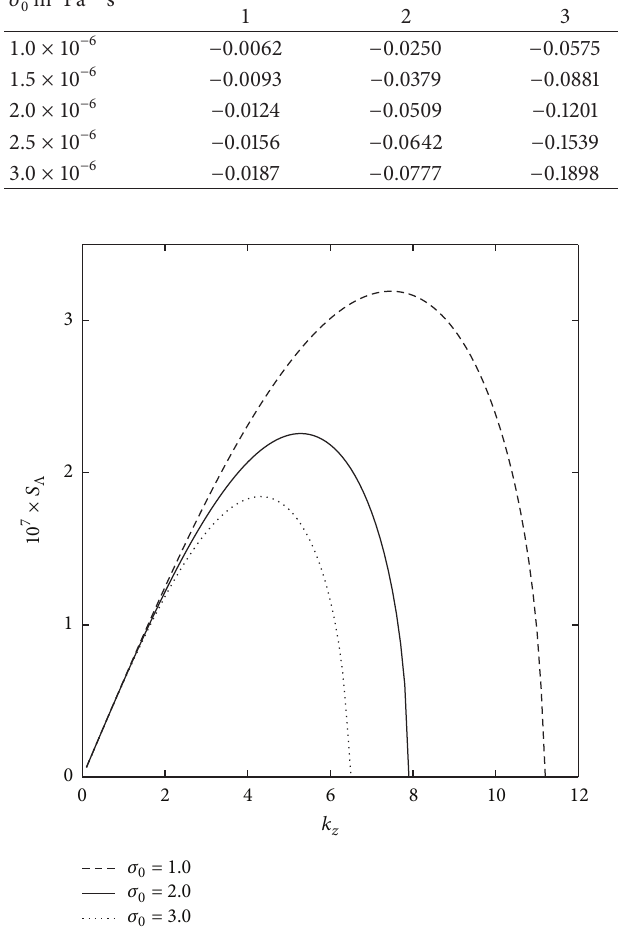
Figure 5: Sensitivity function 𝑆 Λ versus zonal wavenumber 𝑘 𝑧 for different nominal values of the static stability parameter 𝜎 0 (units 10 6 m 2 Pa −2 s −2